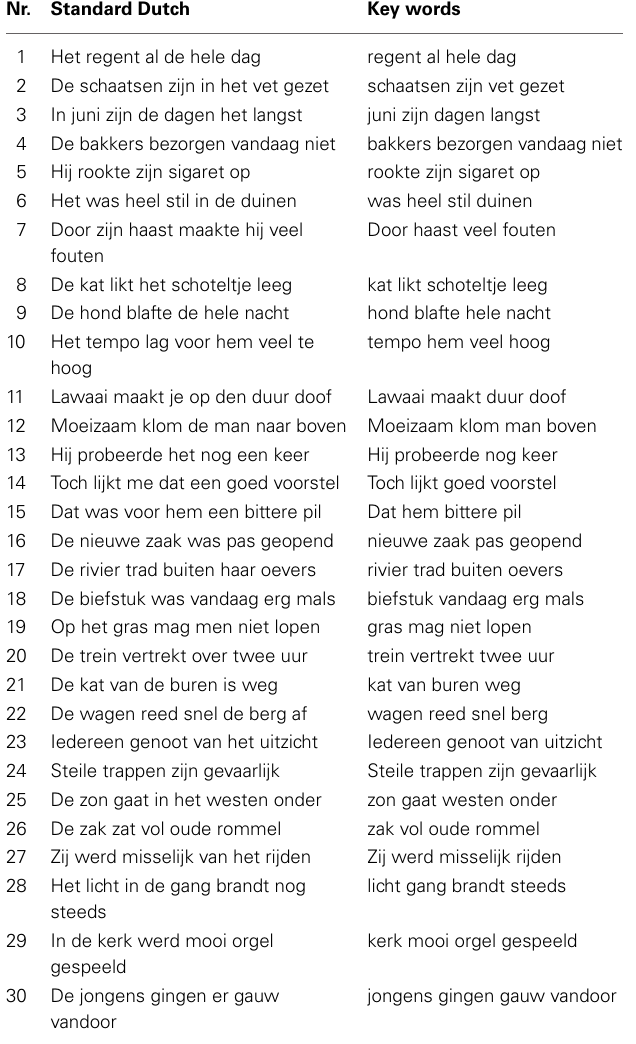
Table A3 | Hearing test sentences, spoken in Standard Dutch. Nr. Standard